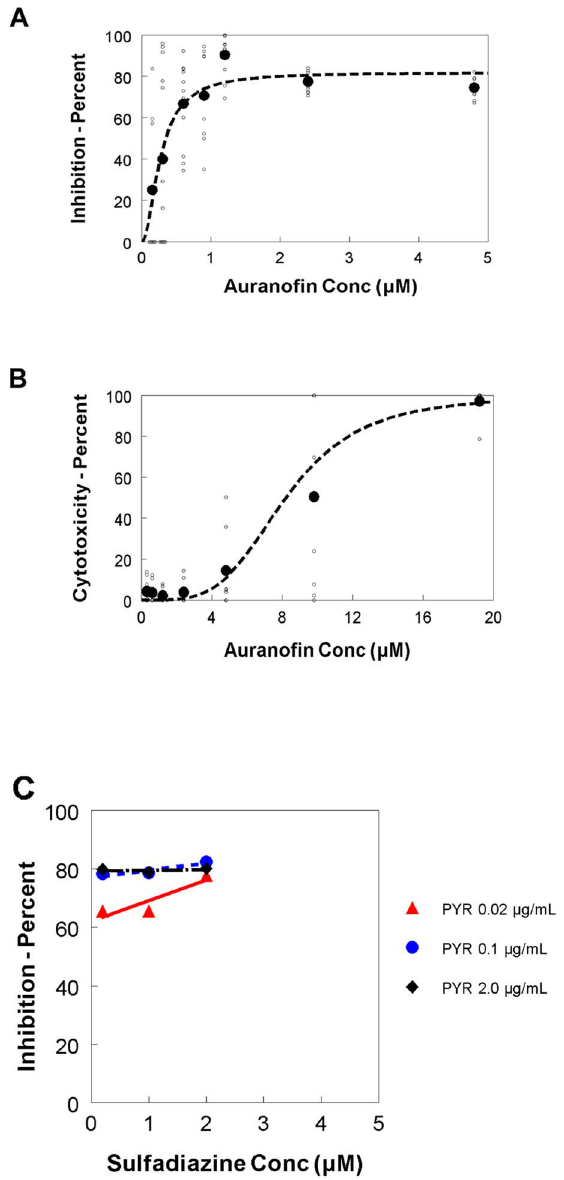
Figure 1. Auranofin effect on the growth of YFP-expressing RH Toxoplasma gondii tachyzoites. A. The percentage of growth inhibition of all observations from 3 independent experiments was plotted for serial two-fold dilutions of auranofin. The different concentrations of auranofin are presented in the X axis. (IC 50 =0.28 m M). B. Cytotoxicity assays showed that auranofin does not affect HFF viability at anti-parasitic doses (TD 50 =8.21 m M for HFFs). C : The percentage of growth inhibition of all observations from 3 independent experiments was plotted for combinations of pyrimethamine/sulfadi- zine by checkerboard method (pyrimethamine doses: 0.02, 0.1 and 0.2 m M; sulfadiazine doses: 0.2, 1 and 2 m M).